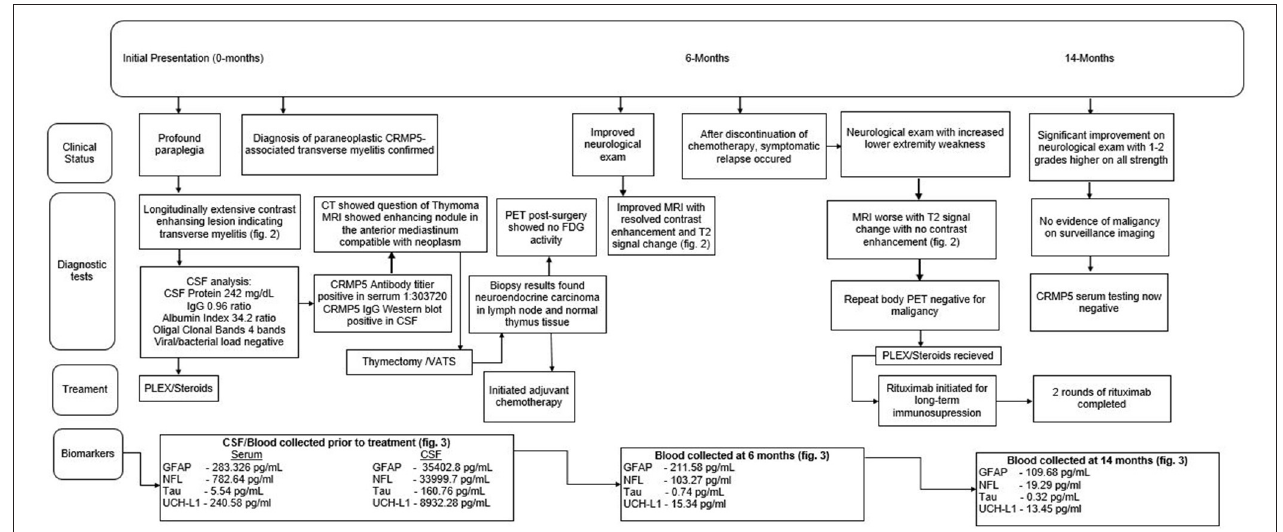
FIGURE 1 | Timeline of clinical course, diagnostic testing, treatment, and biomarker